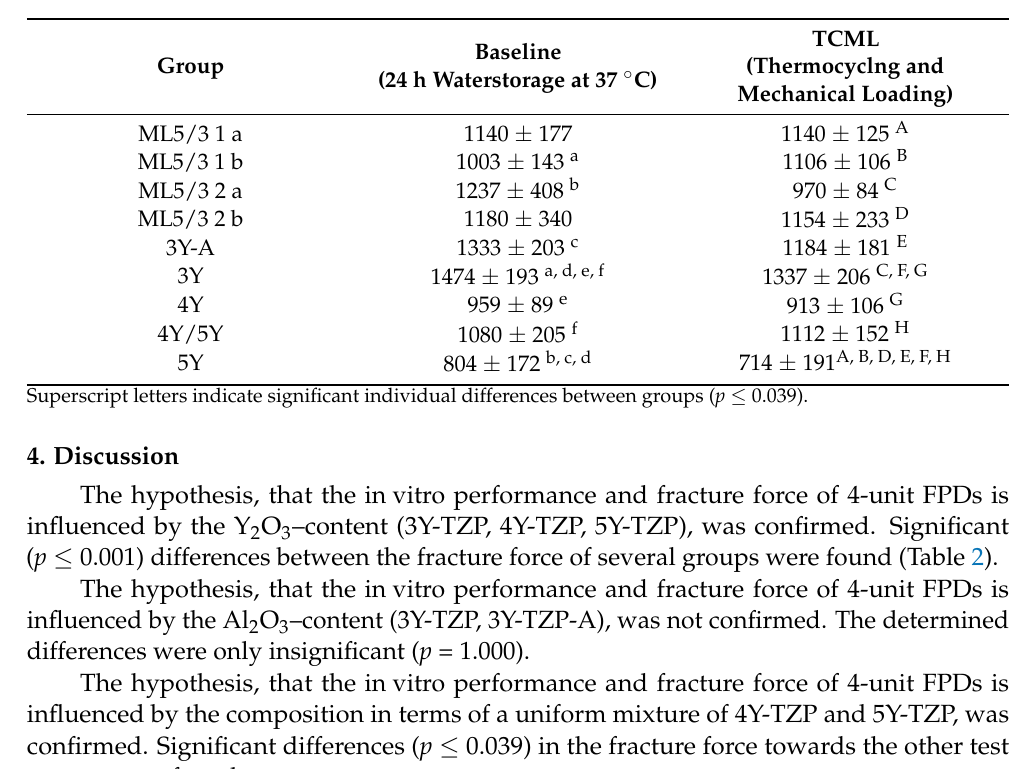
Table 2. Fracture force [N] (mean ± standard